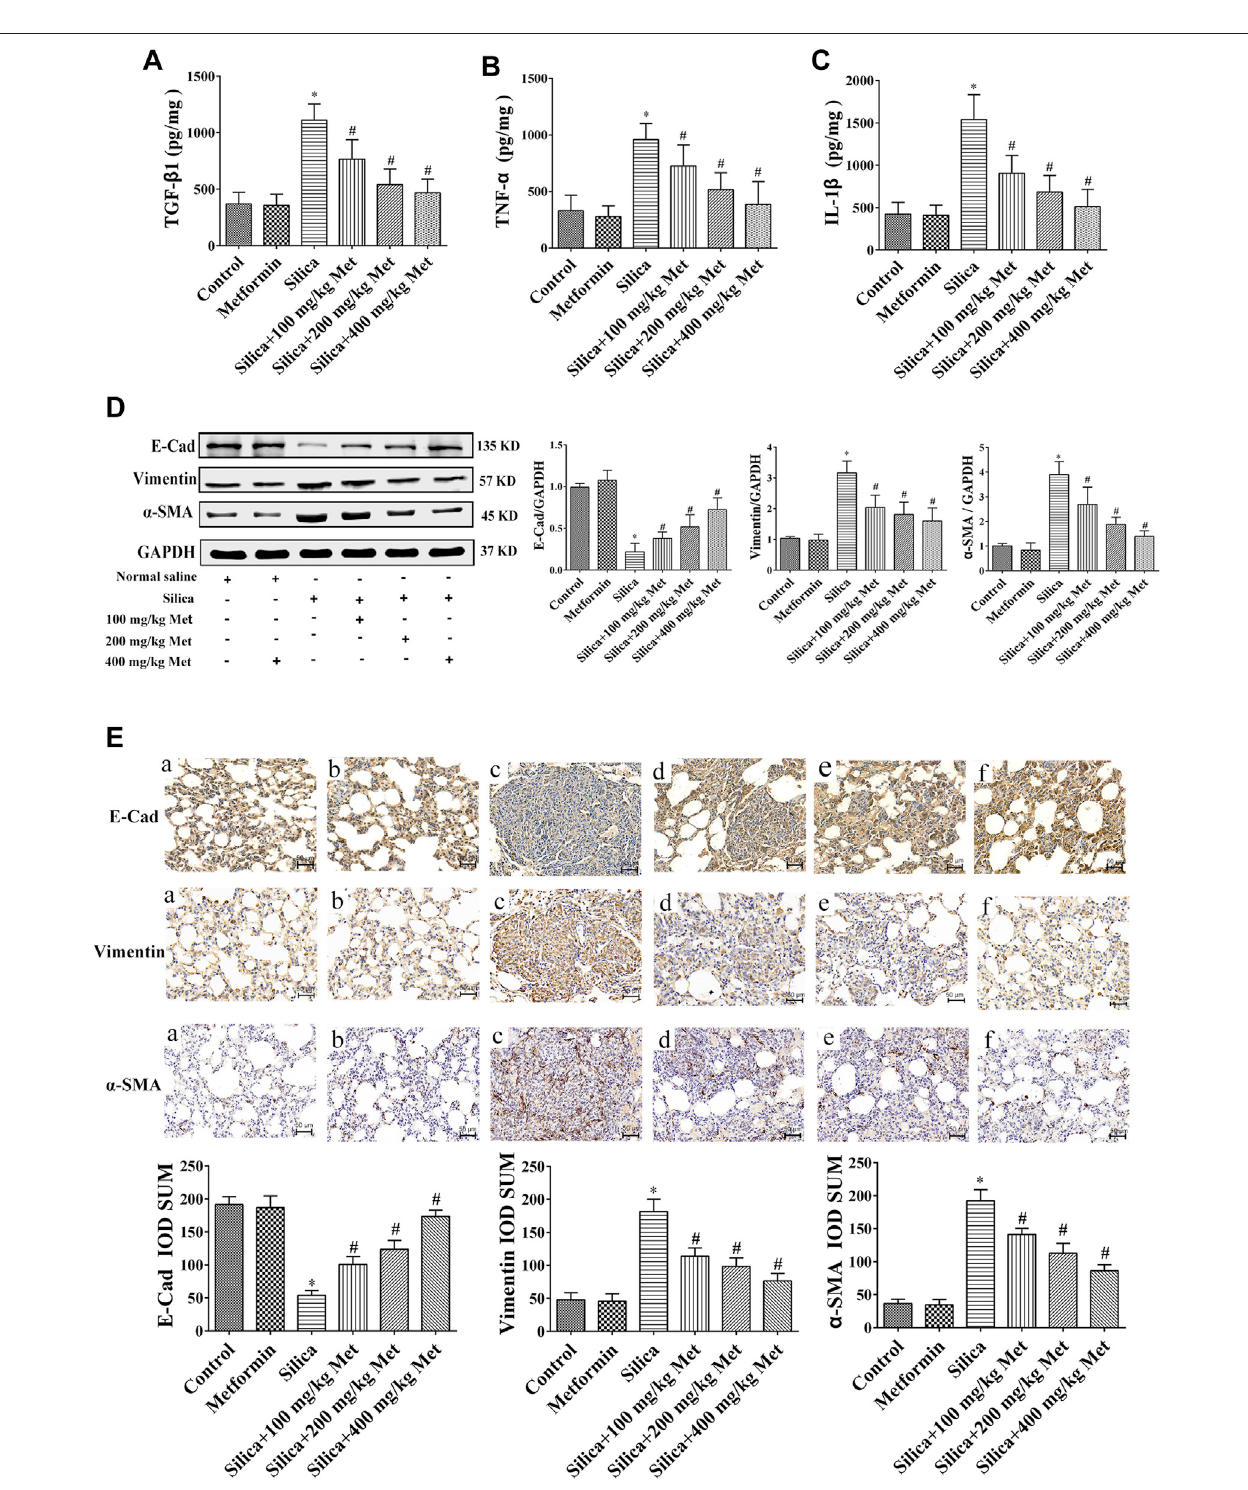
FIGURE 3 | Metformin reduces the expression level of in fl ammatory factors and alleviates silicosis fi brosis induced by silica particles in rat lung tissue. The expression level of (A) TGF- β 1, (B) TNF- α and (C) IL-1 β detected by ELISA. (D) The expressions of EMT-associated proteins expression level in the lung tissue of rats were detected by Western blot and (E) Immunohistochemistry (200 × mag.). a Control group; b Metformin treatment group; c Silica group; d Silica+100 mg/kg metformingroup; e Silica+200 mg/kgmetformingroup; f Silica+400 mg/kgmetformingroup.Allthedataarepresentedasmean ± SD( n (cid:2) 8foreachgroup).* p < 0.05, compared to the negative control group; # p < 0.05, compared to silica group. TGF- β 1, transforming growth factor- β 1; TNF- α , tumor necrosis factor- α ; IL-1 β , interleukin-1 β ; Pro, protein; EMT, epithelial-mesenchymal transition; E-cad, E-Cadherin; α -SMA, α -Smooth muscle actin; Met, metformin.